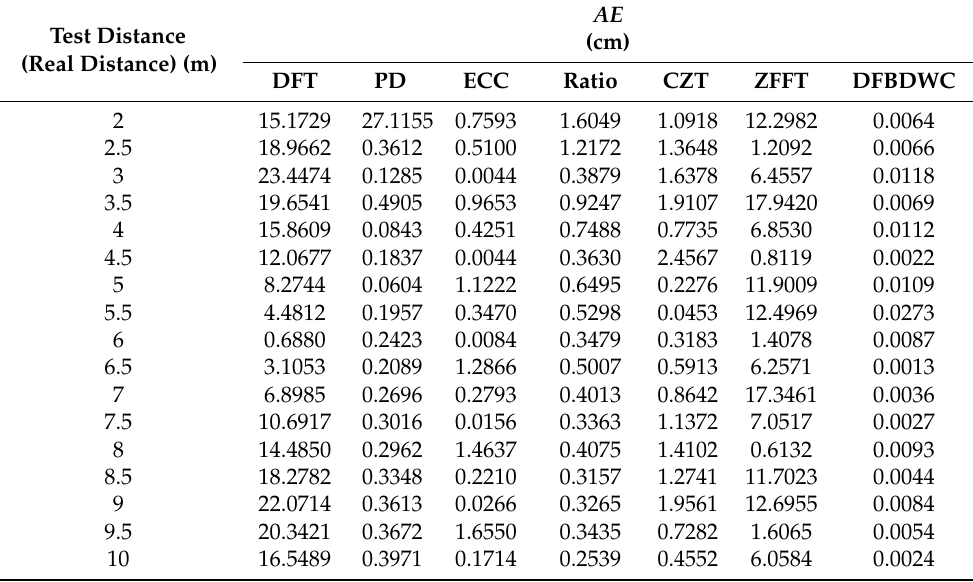
Table 4. Simulation results of AE comparison between seven algorithms. There are no WGN signals in s B ( n )